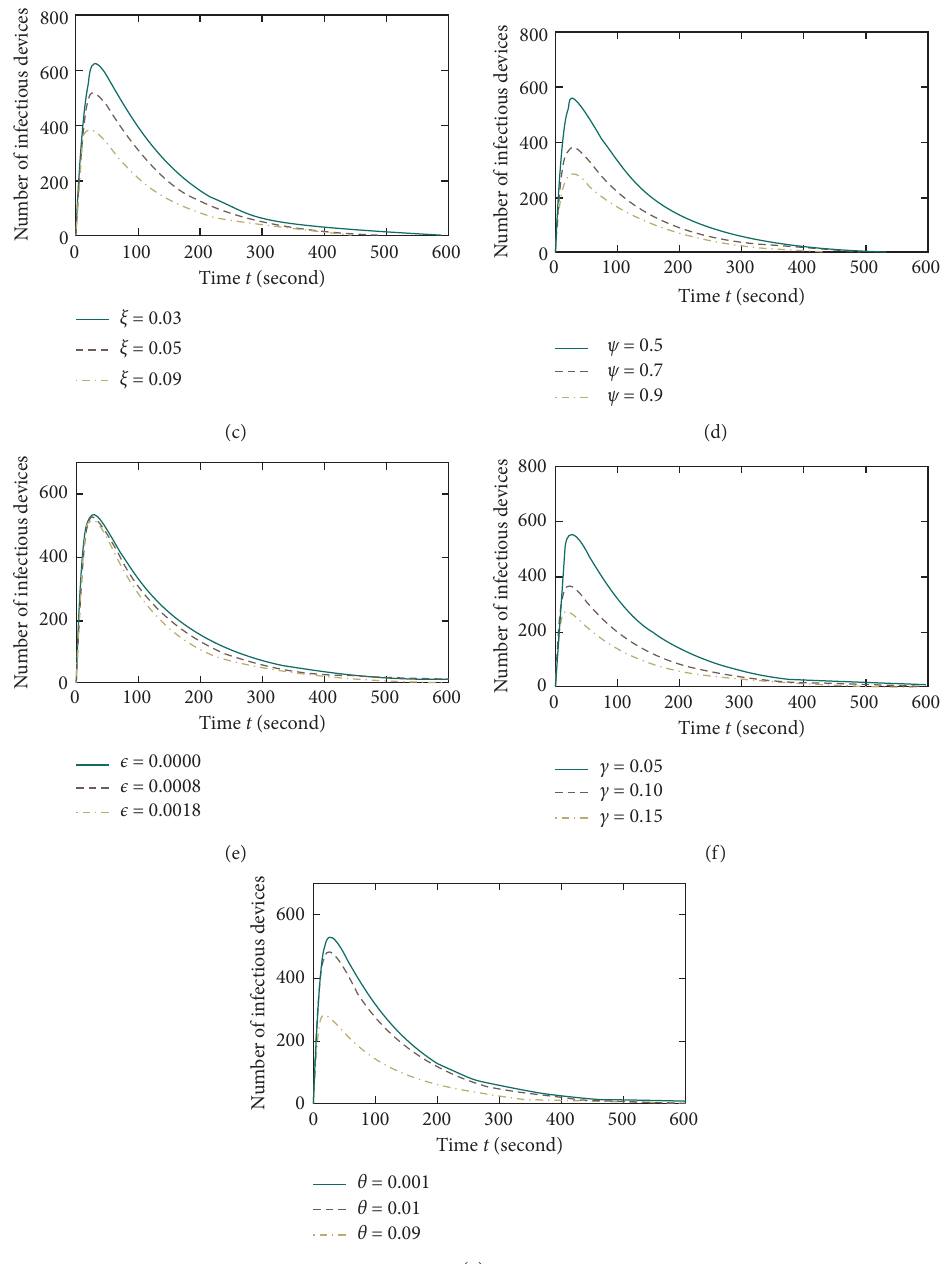
Figure 6: Impacts of modeling parameters on the infectious devices